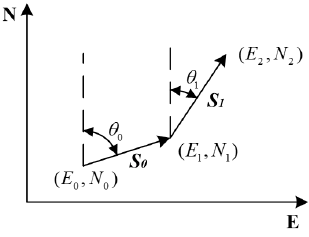
Figure 1. Simple Schematic Diagram of PDR Algorithm.